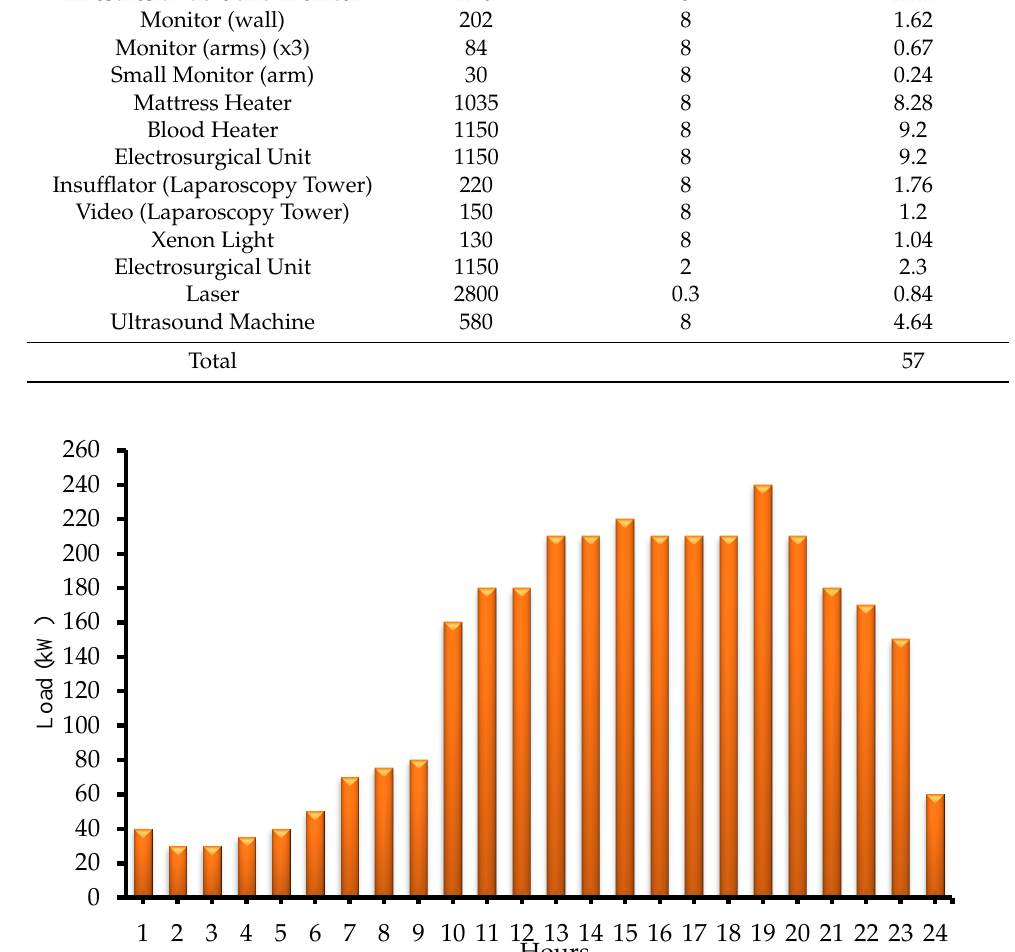
Figure 6. Average hourly load consumption.